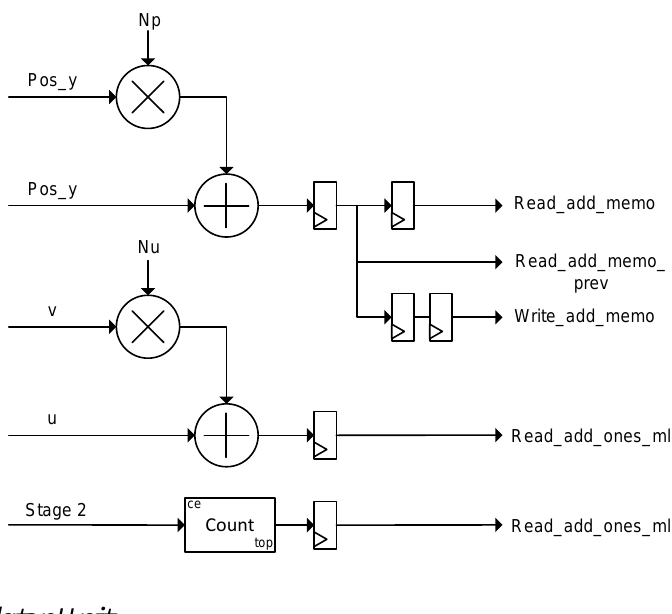
Figure 5. Diagram of the addresses generator.